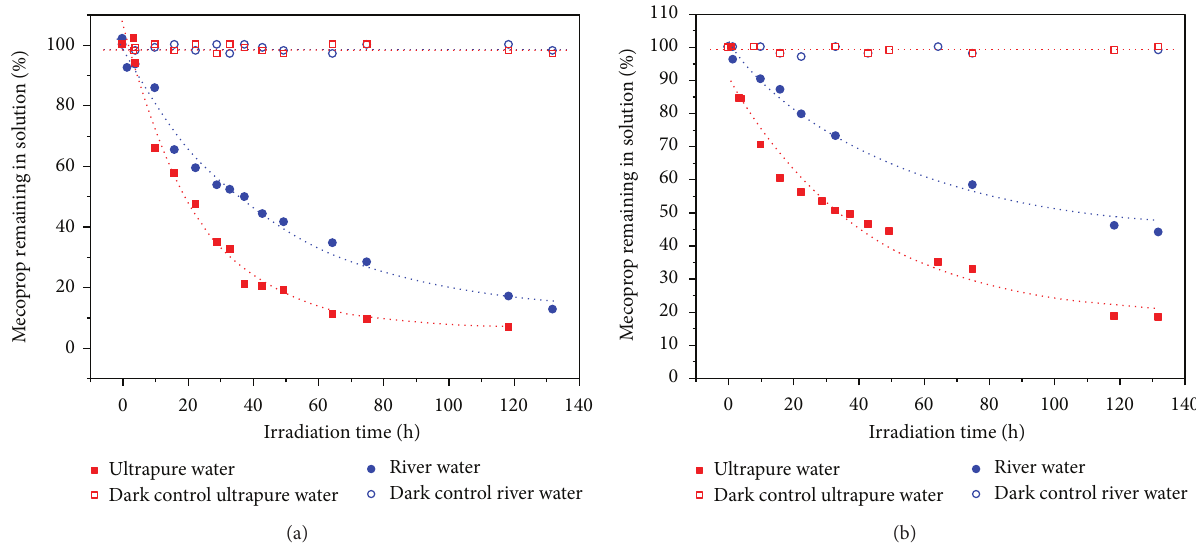
Figure 4: Photodegradation of (a) mecoprop and (b) mecoprop/HP- 𝛽 -CD inclusion complexes in (open red square, solid red square) ultrapure and (open blue circle, solid blue circle) river water under simulated solar irradiation.